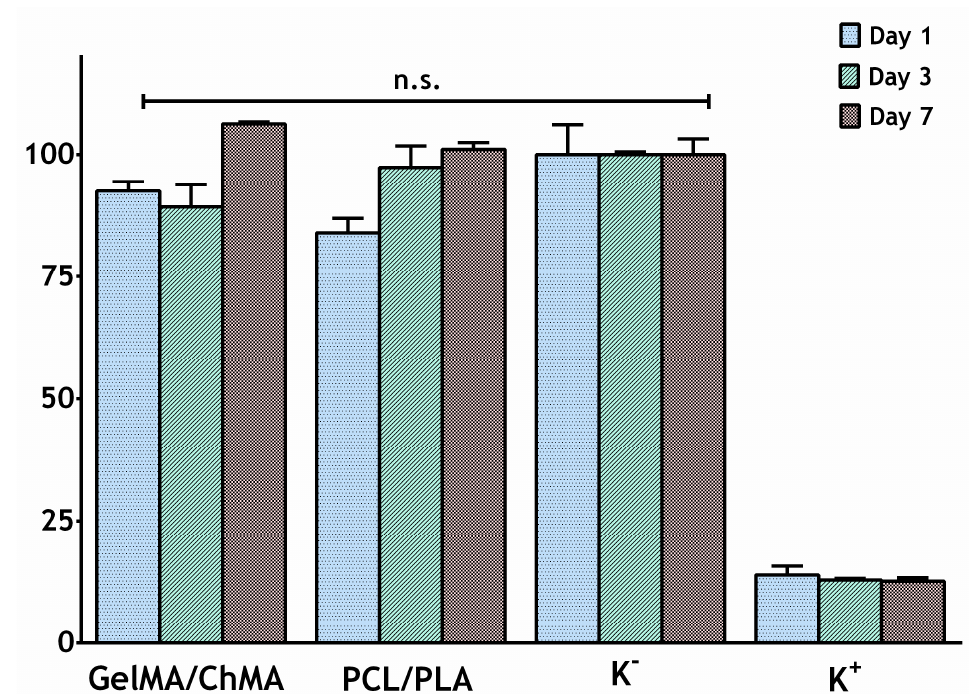
Figure 9. Evaluation of the NHDF cells viability after they be seeded in contact with nanofibrous membranes (PCL/PLA and ChMA/GelMA) for one, three and seven days. K – , negative control; K + , positive control. The statistical analysis of the results was performed using one-way ANOVA with Newman-Keuls test. Result are expressed as mean ± SD (n = 3).